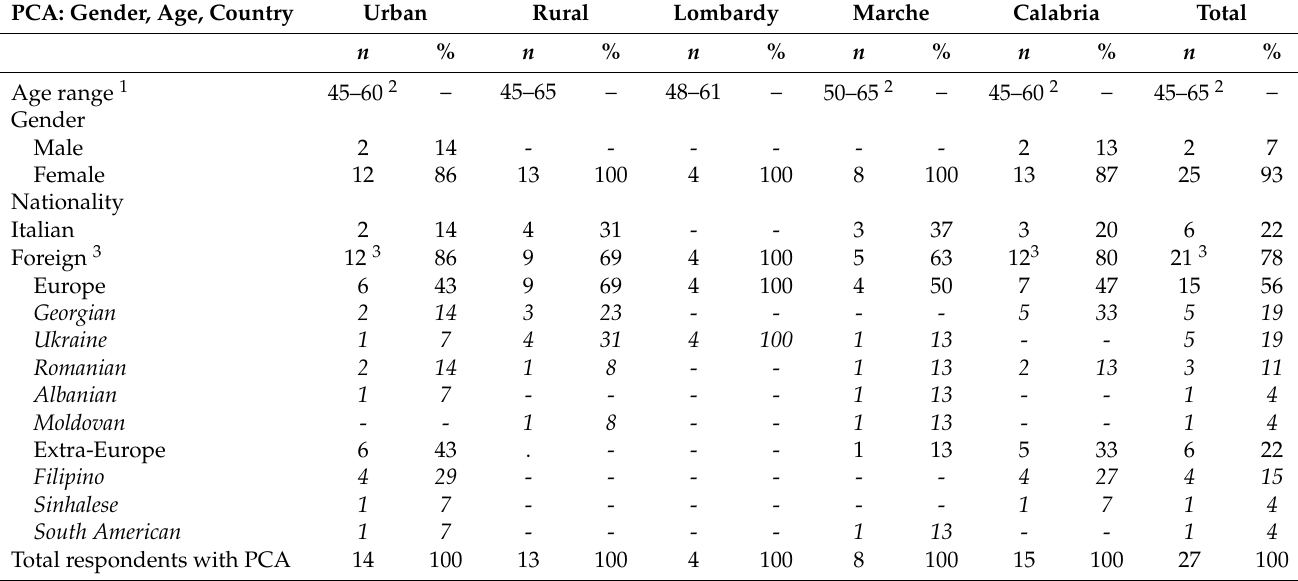
Table 4. PCA presence: age, gender, and nationality, by sites and